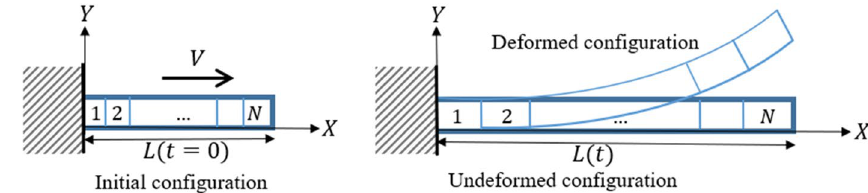
Figure 4. VFE model of flexible body. In the VFE-model, each element changes its length